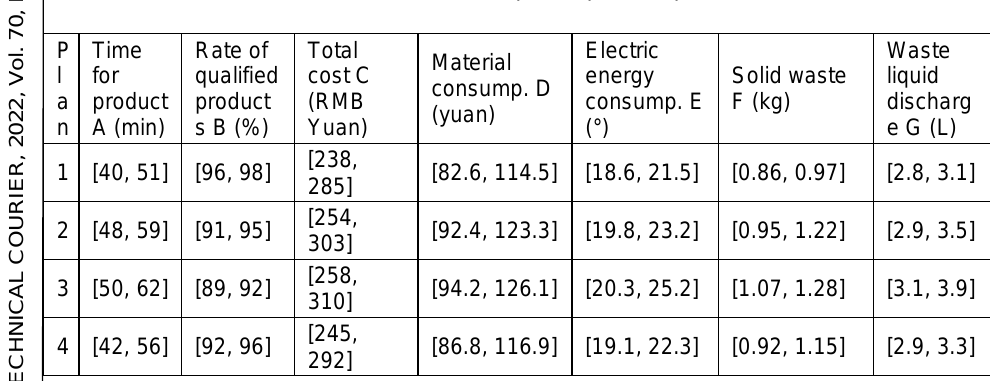
Table 4 – Technical parameters of the four plans